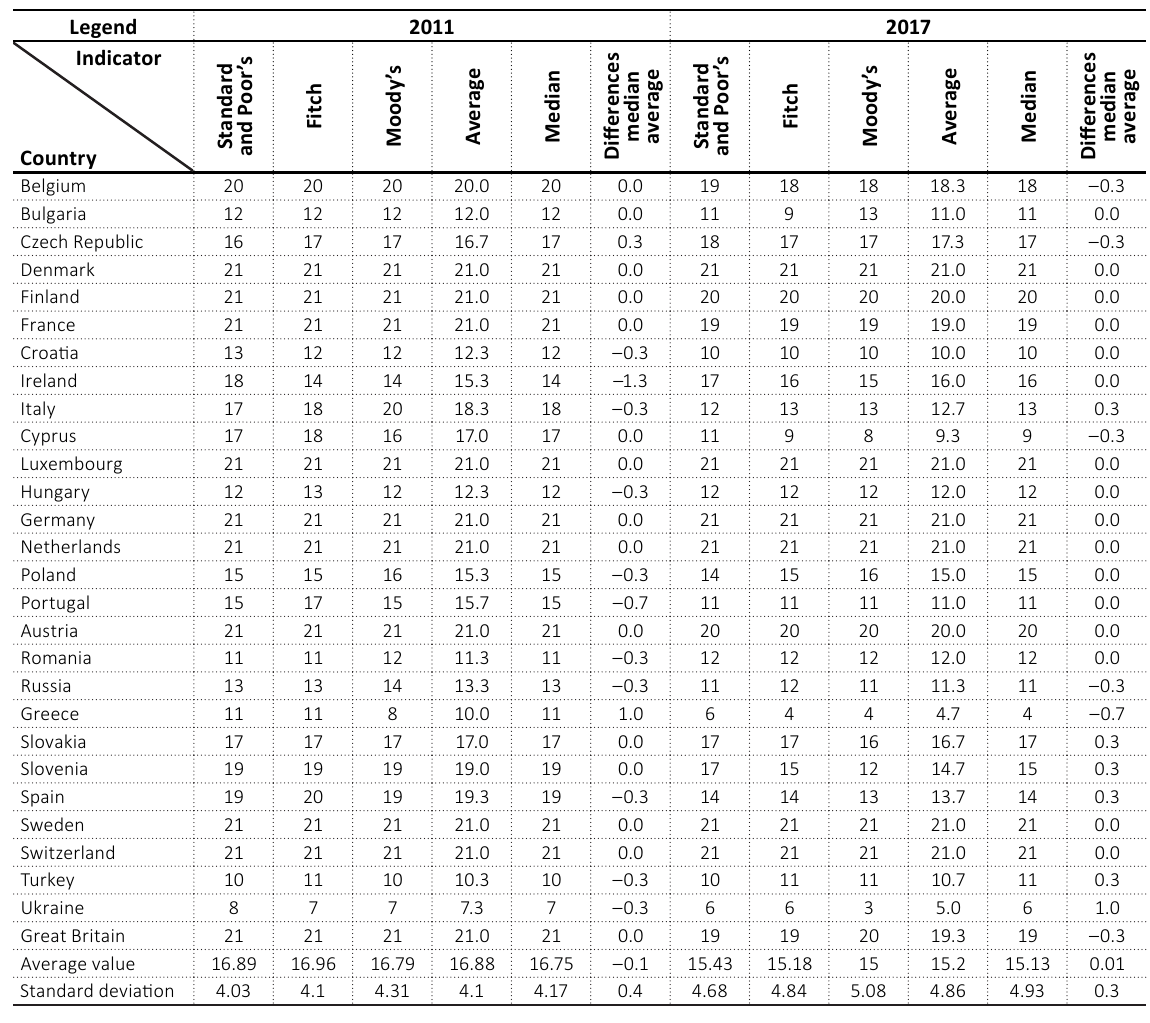
Source: Own processing and